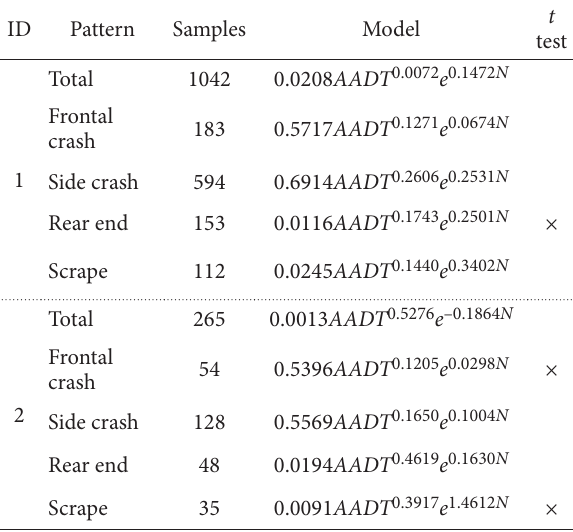
Table 5. Linear regression model by types of